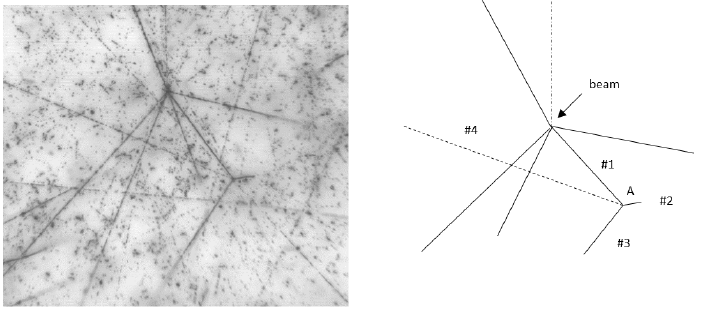
Figure 2. Photograph and schematic drawing of single hypernucleus